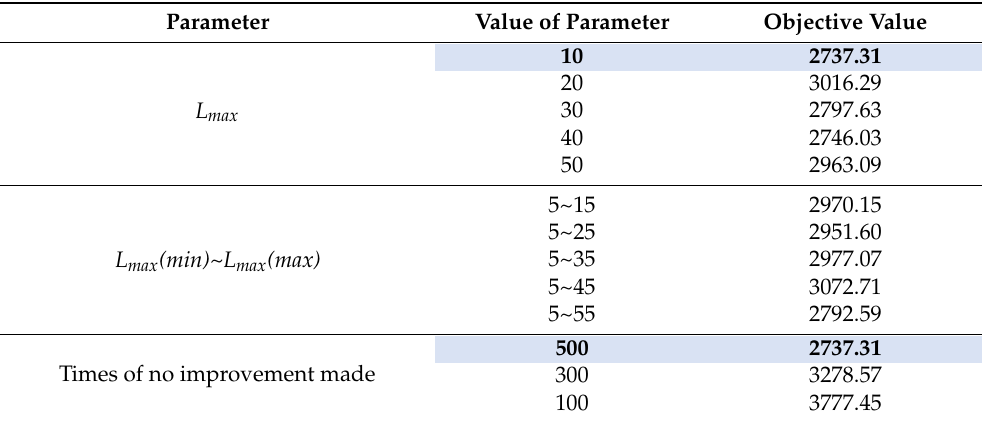
Table 2. Result of the SA parameter experiment.